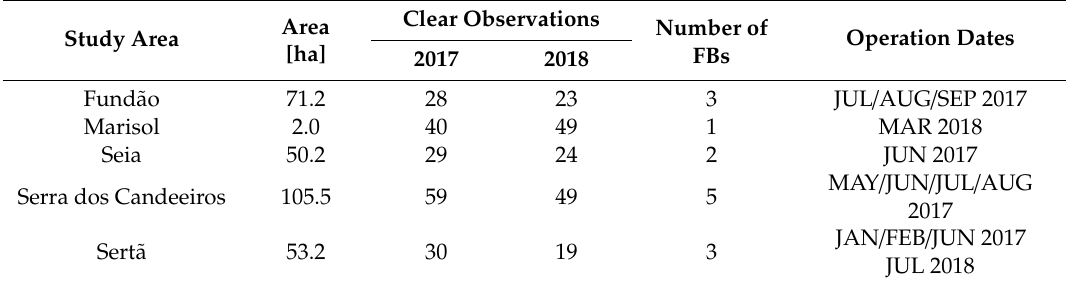
Table 2. Number of clear observations per study area and